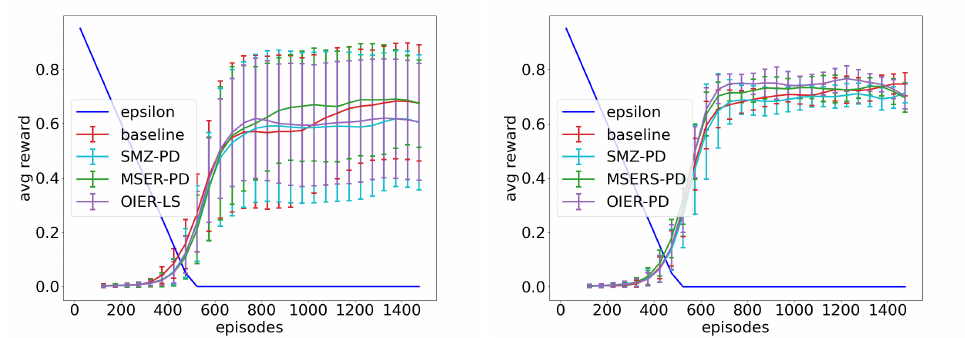
Figure A2. The results for the IER mode: PD and t expl = 500. state encoding: VE. state encoding: